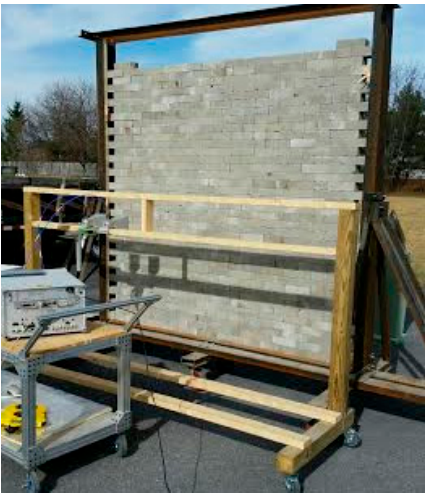
Figure 2. Experimental layout for collecting target returns.